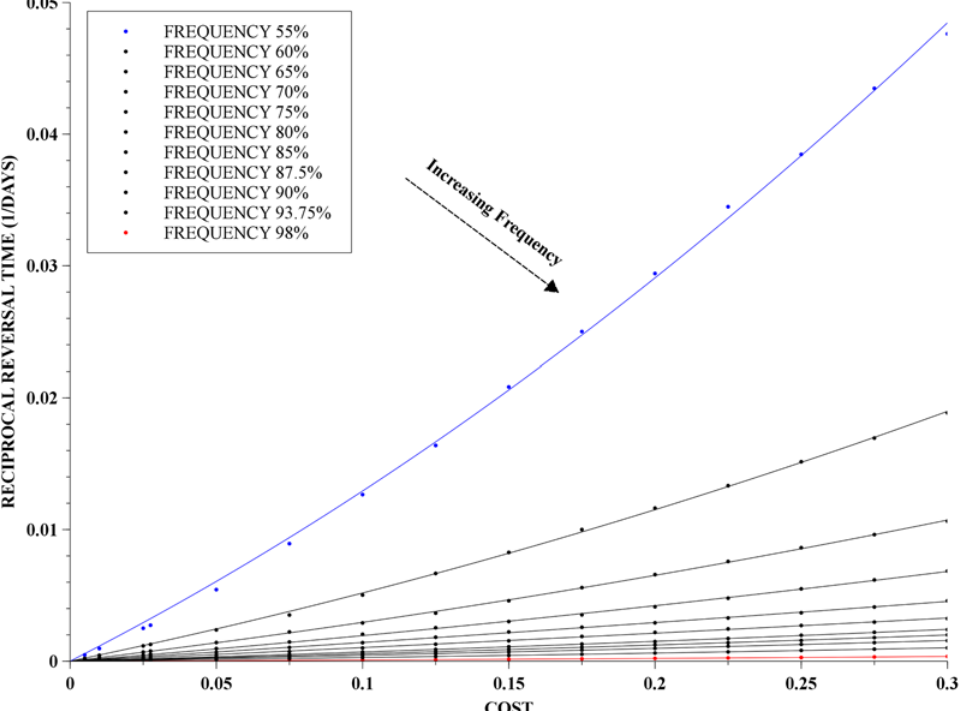
Fig 5. Reciprocal of reversal time as a function of cost. Dependence of the reciprocal of reversal time on the cost together with parabola least-squares fits for each set of points of the same initial frequency of the resistance allele. The costs vary from 0.005 up to 0.3 and the frequencies of the resistance allele were in the range of 55% to